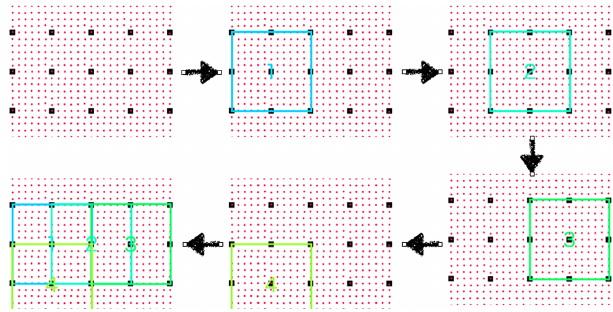
Figure 9. Segmentation strategy adopted for downscaling on a 2-D plane (cid:127) 2-D . A patch or segment S ij is defined for each WRF-ARW grid mass point (black squares) containing many ALYA-CFDWind grid points (red small squares). The last plot shows the overlapped